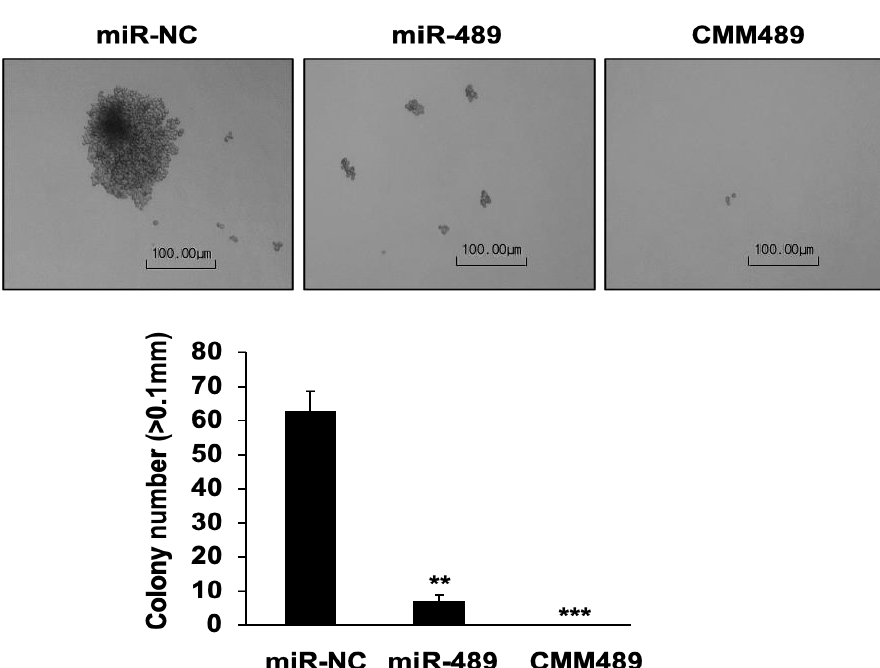
Figure 3. Enhanced therapeutic efficacies of CMM489 in TNBC cells. ( A ) Schematic description of CMM489. Uracil in miR-489 is replaced by 5-FU (red) in CMM489. ( B ) Western blotting analysis of SUZ-12, MDC-1 and GAPDH (left) and TS-FdUMP-TS and beta actin (right) from lysates of MDA-MB-231 and BT-549 cells transfected with none, miR-NC, miR-489, CMM489 or treated with 30 M 5-FU. Densitometric analysis was performed using Image J. Representative images were carried out at least three times. ( C ) The rate of proliferation was monitored by cell counting MDA-MB-231 cells transfected with 100 nM of indicated miRs using oligofectamine at 1–6 days. Column, mean from three independent experiments; bars, SD. ** p < 0.01, *** p < 0.001. ( D ) MDA-MB-231 cells transfected with the indicated miRNAs were stained with propidium iodidie (PI) and the percentage of cell population in each cell cycle phase was analyzed by flow cytometry. Representative images were selected from three independent experiments. All data are presented as the means ± SD. * p < 0.05. ( E ) Inhibition of cell motility in MDA-MB-231 cells transfected with miR-NC, miR-489 or CMM489 was measured using a transwell assay. The ability of cells to migrate toward 100nM LPA as chemoattractants was quantified by counting the cells per square milliliter using bright-field optics. Column, mean from three independent experiments; bars, SD. * p < 0.05, *** p < 0.001 compared with the control. ( F ) MDA-MB-231 cells expressing miR-NC, miR-489 and CMM489 were cultured in soft agar-containing growth medium after 10 days. Colony formation was captured at 10x magnification. Only cell colonies >0.1 mm in diameter were counted. Representative images were carried out at least 3 times. Scale bar: 100 μm . All data are presented as the means ± SD. ** p < 0.01, *** p < 0.001.